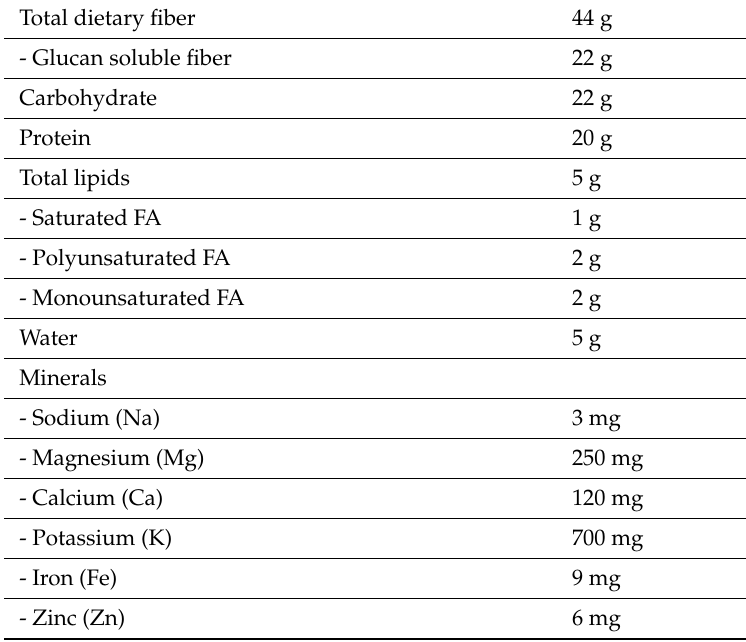
Table 1. Nutritional composition per 100 g of OatWell ®